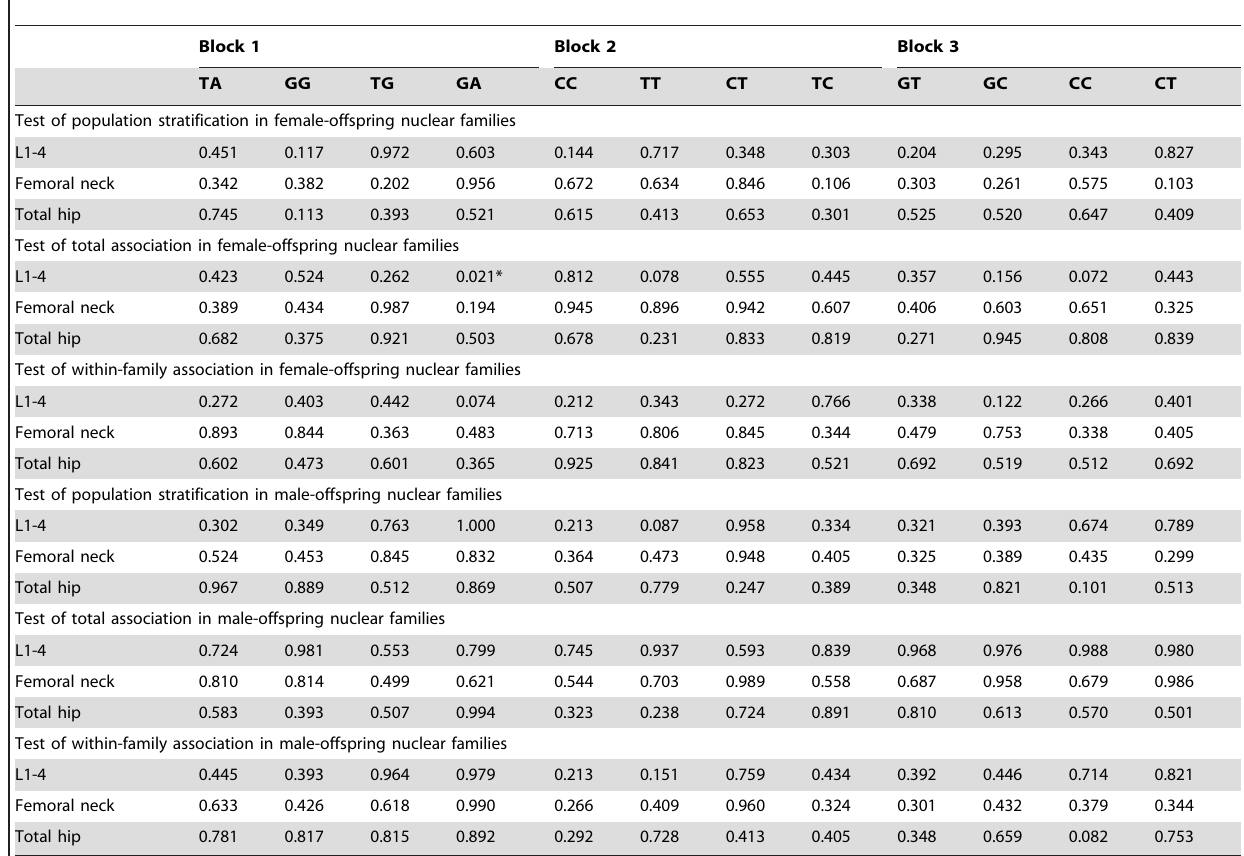
Table 4. P values obtained for analyses of population stratification, total association and within-family association for four haplotypes of block